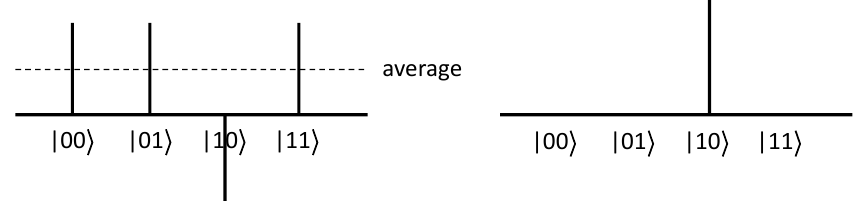
Figure 6. After performing oracle ( left ) and diffusion operator ( right ).